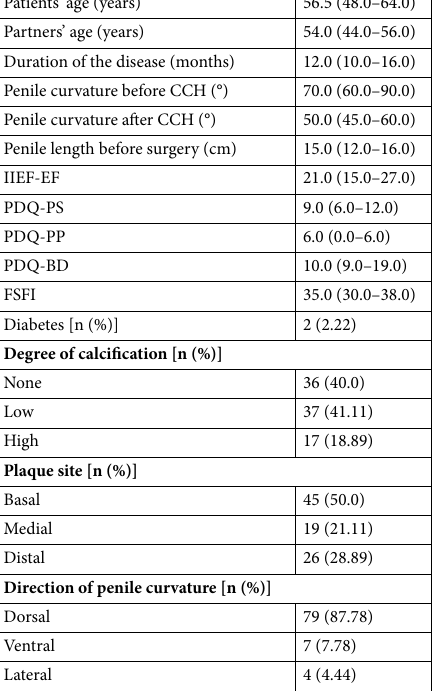
Table 1. Baseline descriptive statistics (n = 90). Data are expresses as medians (IQR). IQR interquartile range, IIEF international index of erectile function, CCH collagenase Clostridium histolyticum , PDQ Peyronie’s disease questionnaire, FSFI female sexual function index.